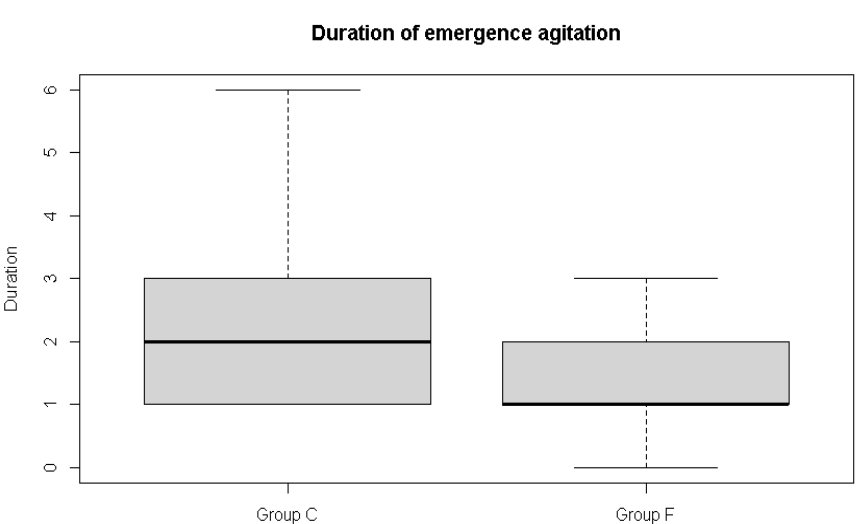
Figure 3. Box and whisker plot showing duration of emergence agitation in the control group and the flumazenil group. The median is represented as a line located in the middle of the box. The top and bottom of the box are the 75th and 25th percentiles, respectively, and the ends of the whiskers are the ±1.5 × interquartile range.